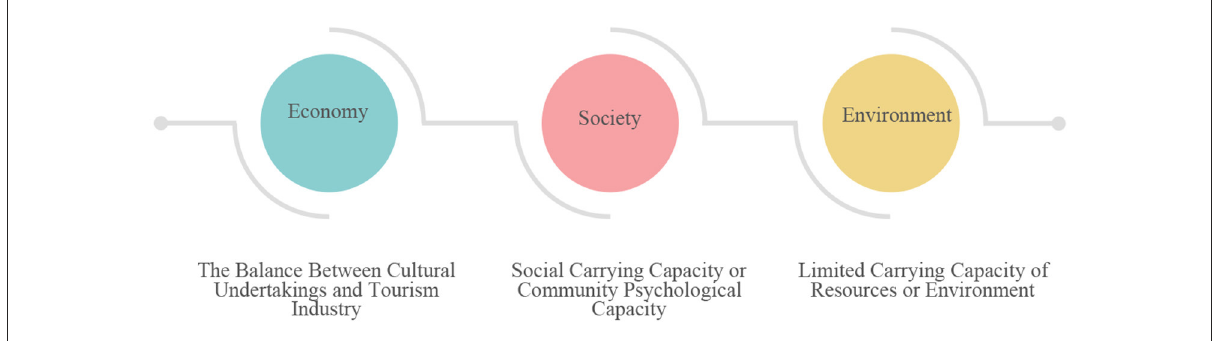
FIGURE6 The “triple bottom line” in the integration development of culture and